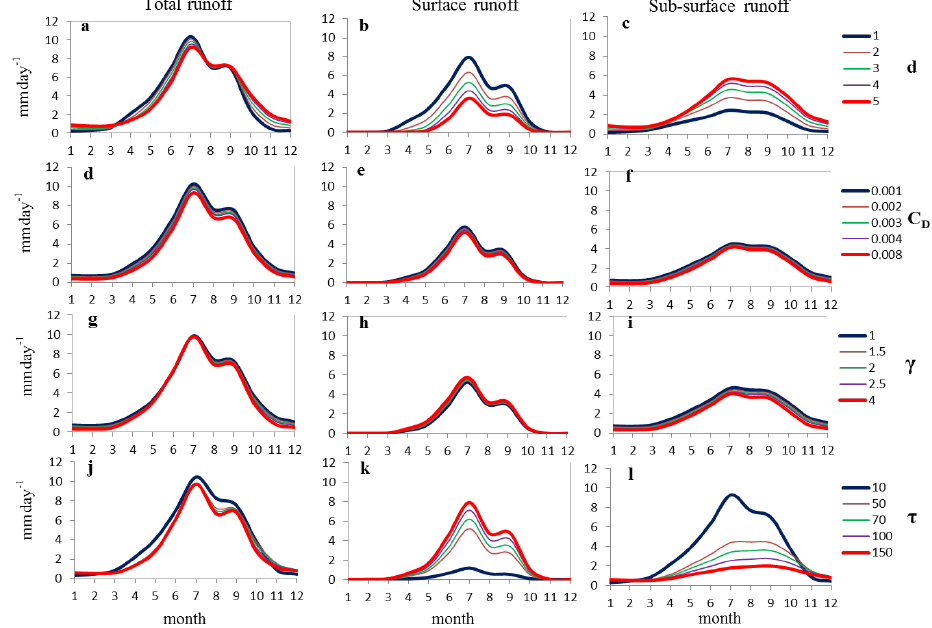
Figure 3. The 11-year (1980–1990) mean seasonal cycles of the simulated total runoff, surface runoff and subsurface runoff (mmday − 1 ) in the Brahmaputra Basin. Each of the five lines in each panel represents the average of 5 3 (125) runs with one of the four calibration parameters fixed at a given reasonable